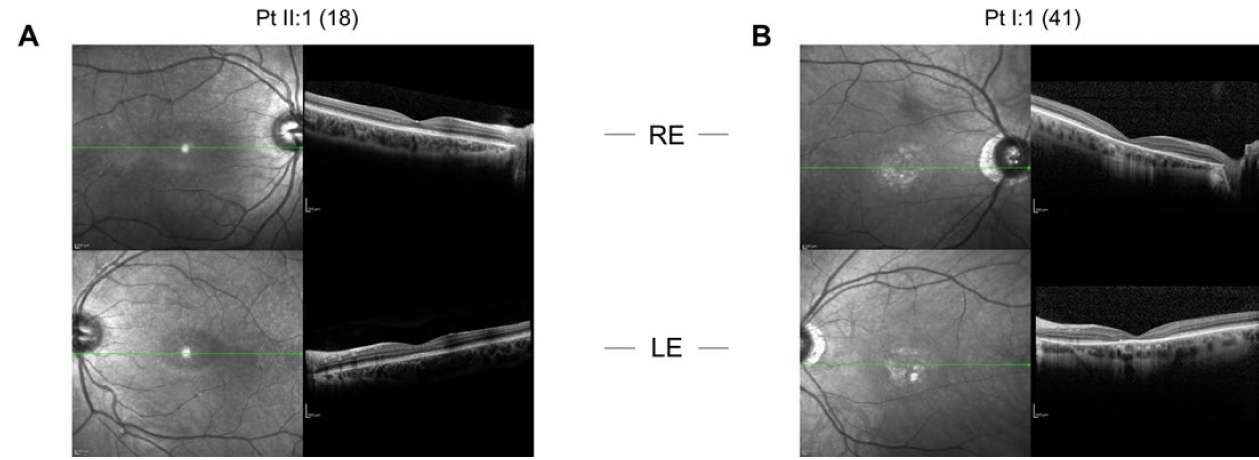
Figure 2. Spectral-domain optical coherence tomography (SD-OCT) scans of the right (upper panels) and left eyes (lower panels) of ( A ) the proband at the age of 18 and ( B ) of patient 2 I:1 at the age of 41. The green line indicates the interdigitation zone.